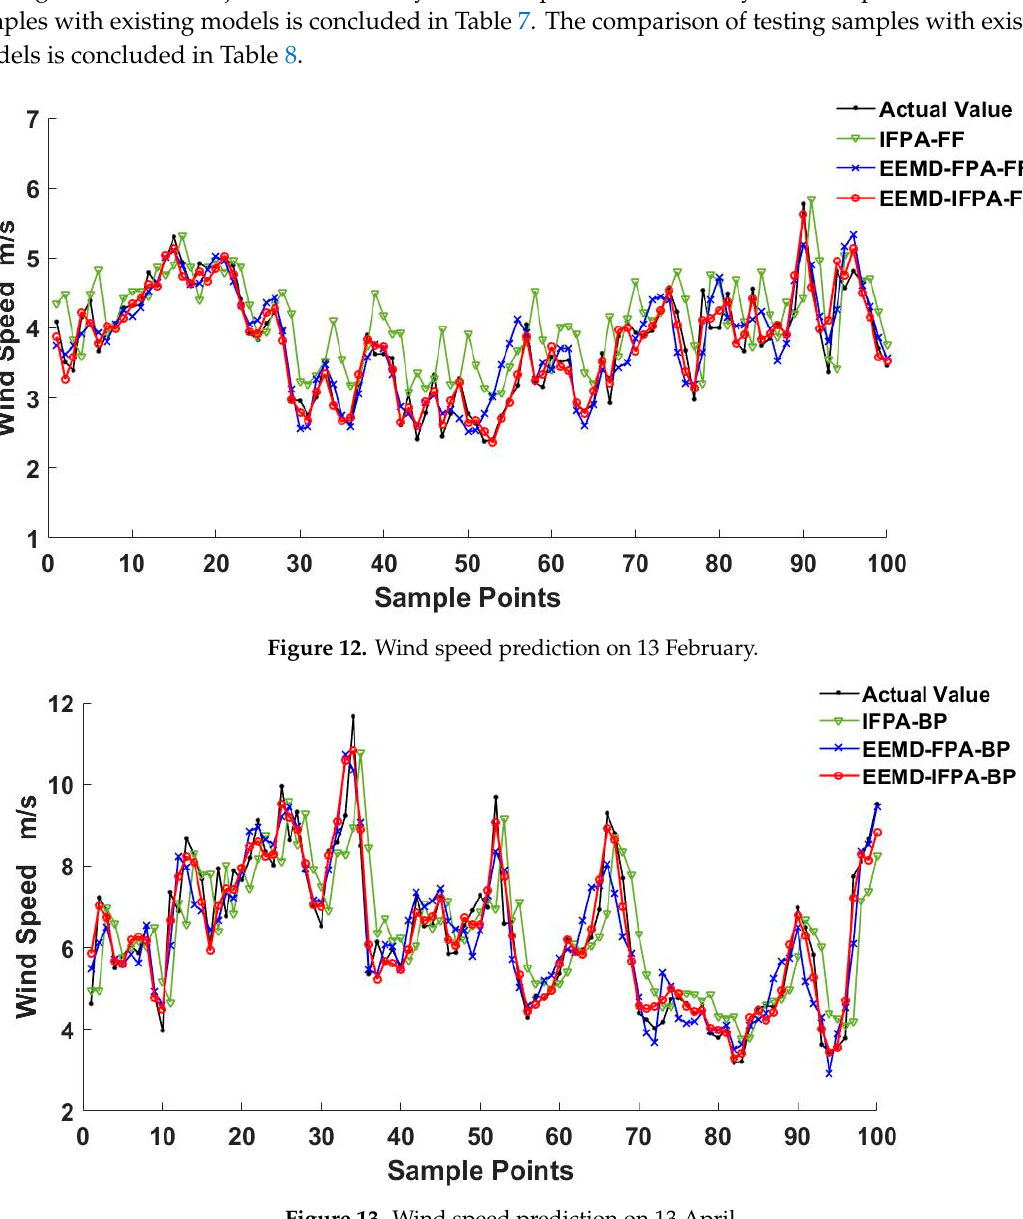
Figure 13. Wind speed prediction on 13 April.